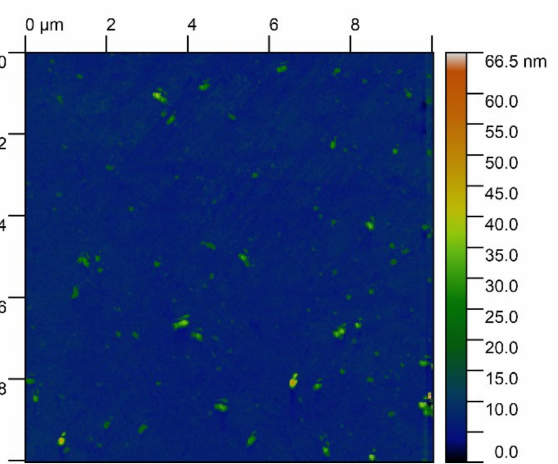
Figure 2. Representative image of surface roughness for soda-lime glass